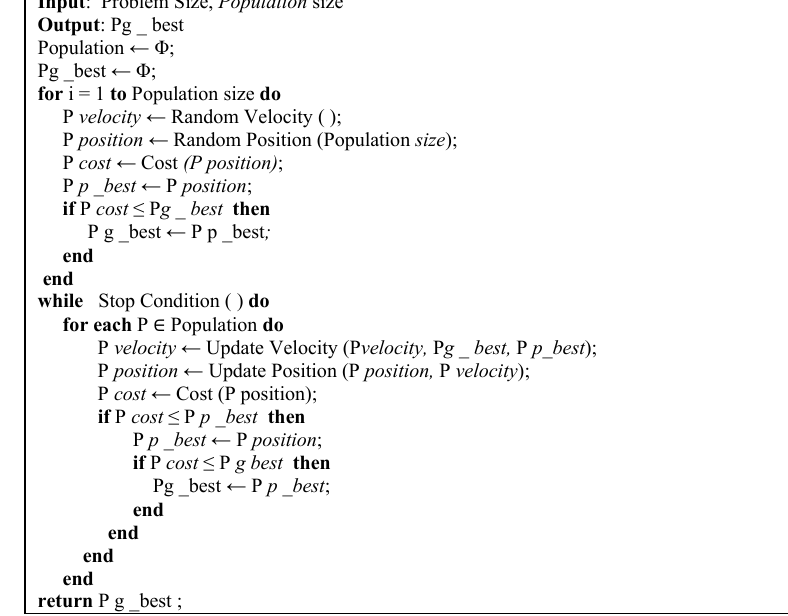
Fig. 4. Pseudo code for Particle Swarm Optimization Algorithm for Minimum Cost